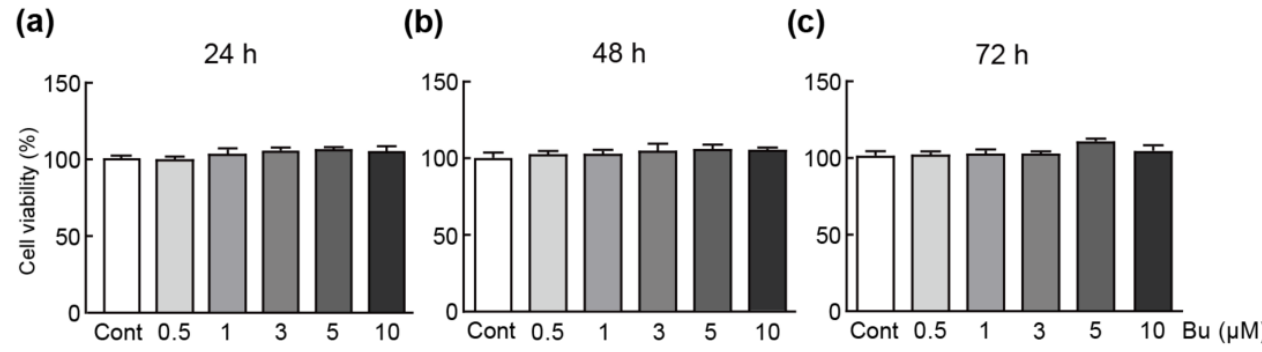
Figure 1. Cytotoxic effects of butein in H9c2 cardiomyoblasts. An MTT assay was performed to measure the cell viability. The cells were treated with various concentrations of butein (0.5, 1, 3, 5, and 10 µM) for 24 ( a ), 48 ( b ), and 72 h ( c ). The results are shown as the mean ± SEM in triplicate. Cont; control, Bu; butein.